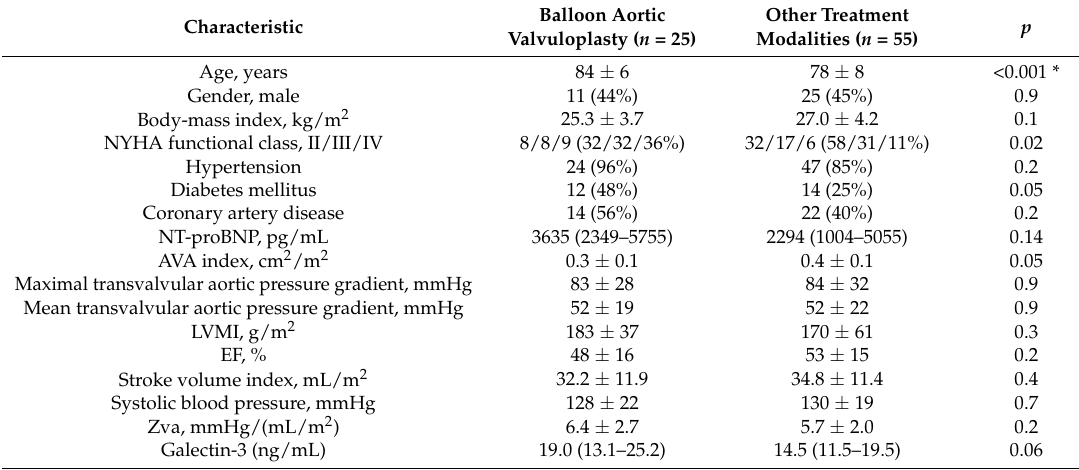
Table 4. Patients’ characteristics according to treatment modality.